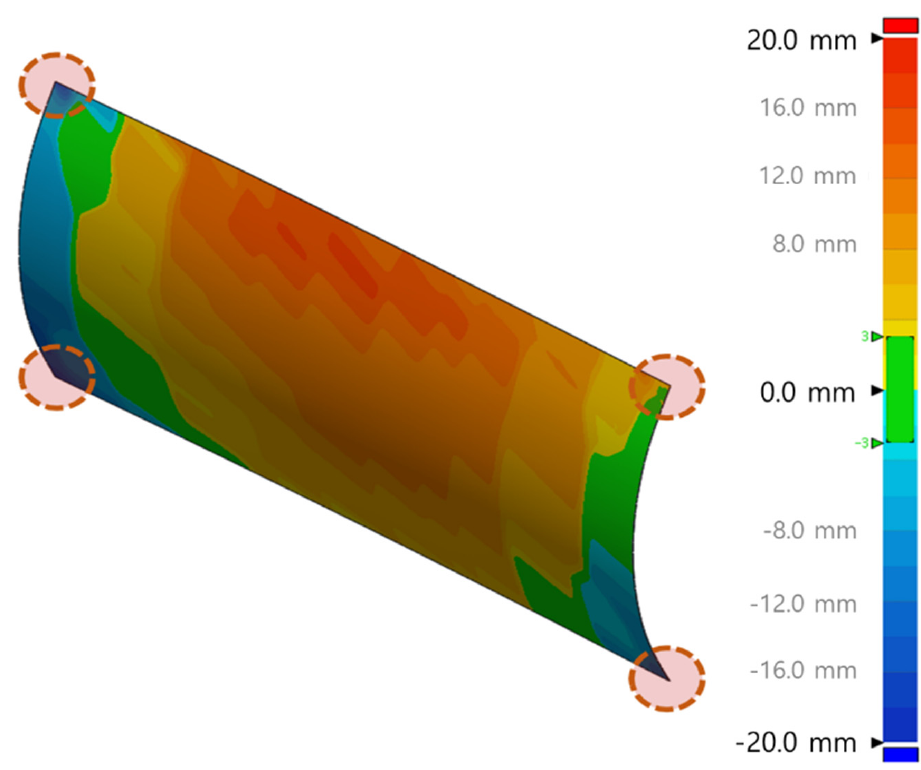
Figure 11. Coordination reference shape and target shape (Case 1).